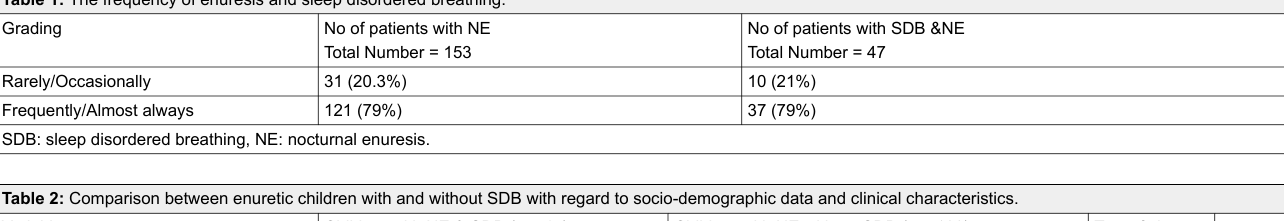
Table 2: Comparison between enuretic children with and without SDB with regard to socio-demographic data and clinical characteristics. Variable